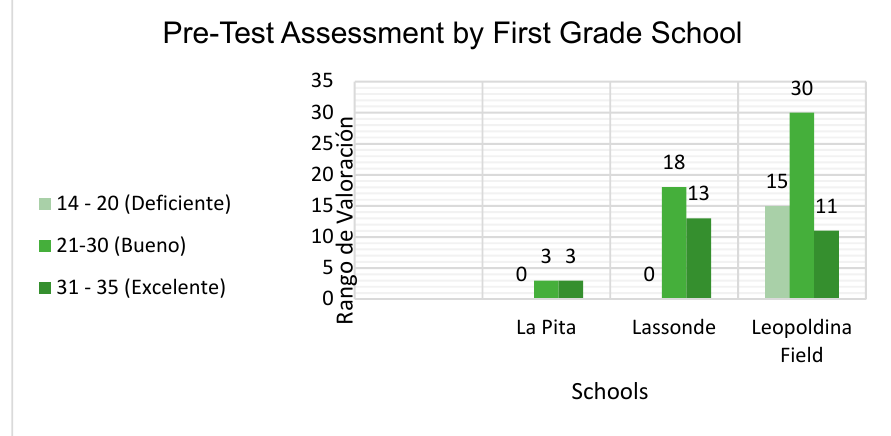
Figure 11. Assessment of the pre-test to first grade